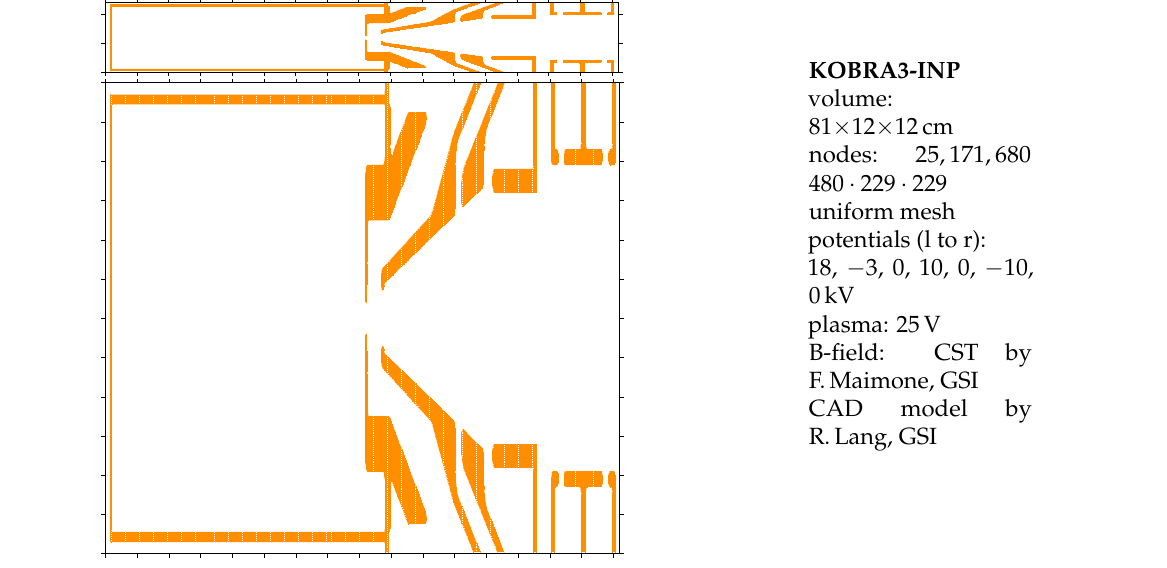
Figure 5. HIISI computer model. Top: correct aspect ratio, bottom: enlarged